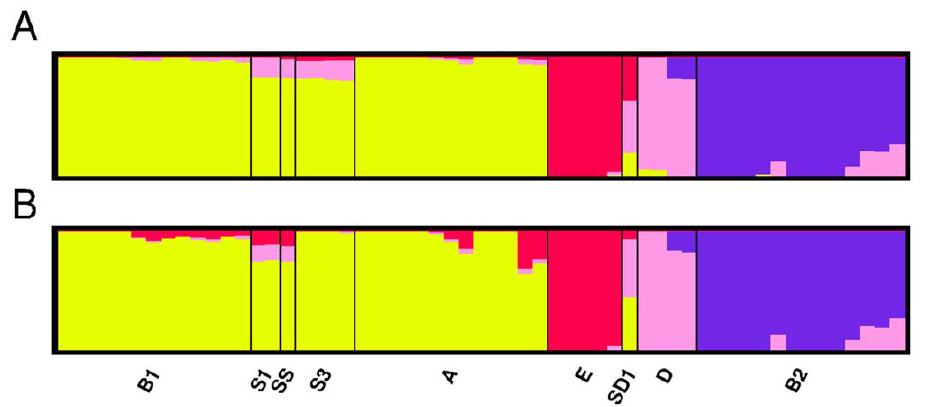
Figure 2. Population clusters of the Escherichia and Shigella strains. A), all 2085 universally present genes were analyzed. B), universally present recombinant genes were excluded. Proportions of ancestry were inferred using STRUCTURE [35] by assuming four groups (K=4), and displayed with DISTRUCT [67]. Each column represents one genome, and the genome order is as in Figure 1.